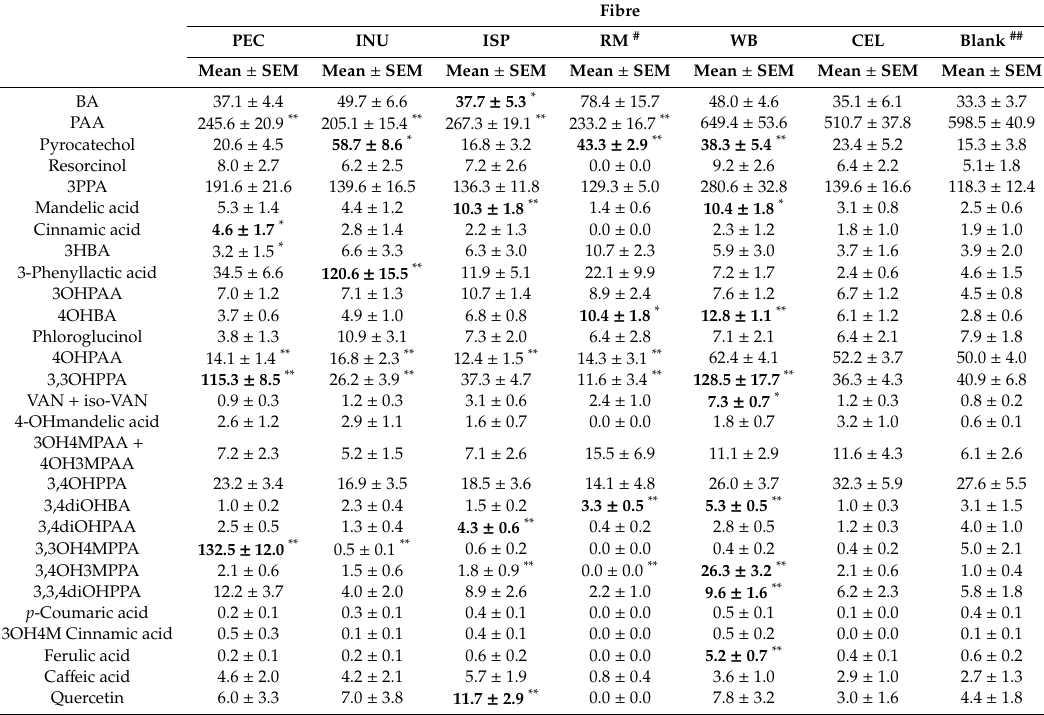
Figure 1. Relative profile of phenolic metabolites (rel% AUC 24 ) released from fibres present in the medium in fermentation vials with rutin added (R+, 20 µg/mL) and without rutin (R-); INU, inulin, PEC, pectin, ISP, psyllium, RM, pyrodextrin, WB, wheat bran, CEL, cellulose; n = 10. The light pink bar refers to the main metabolite of rutin and shows its rather low proportion in the whole pool of phenolic acid metabolites present. For other abbreviations, see Materials and Methods section. Table 1. Area under the curve (AUC 24 ) of phenolics found in fermentation slurries with fibres only (rutin not added) at 0.8 g/50 mL, AUC 24 µg/mL/24 h.